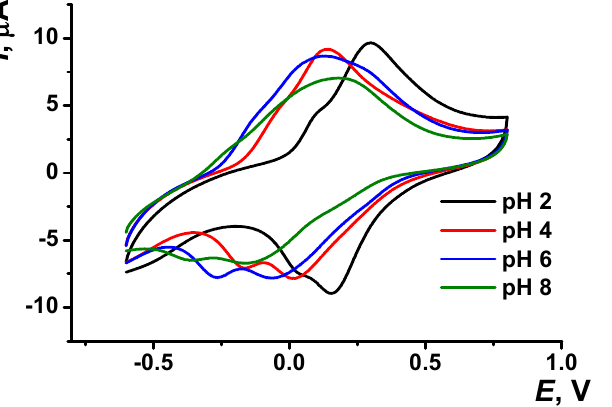
Figure 3. Cyclic voltammogram recorded on the GCE modified with poly(Azure A) in 0.1 M phos- phate buffer at different pH values; scan rate 100 mV/s.